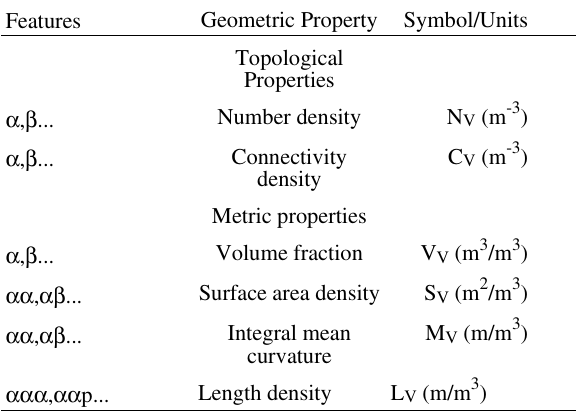
Table 2. Geometric properties of feature